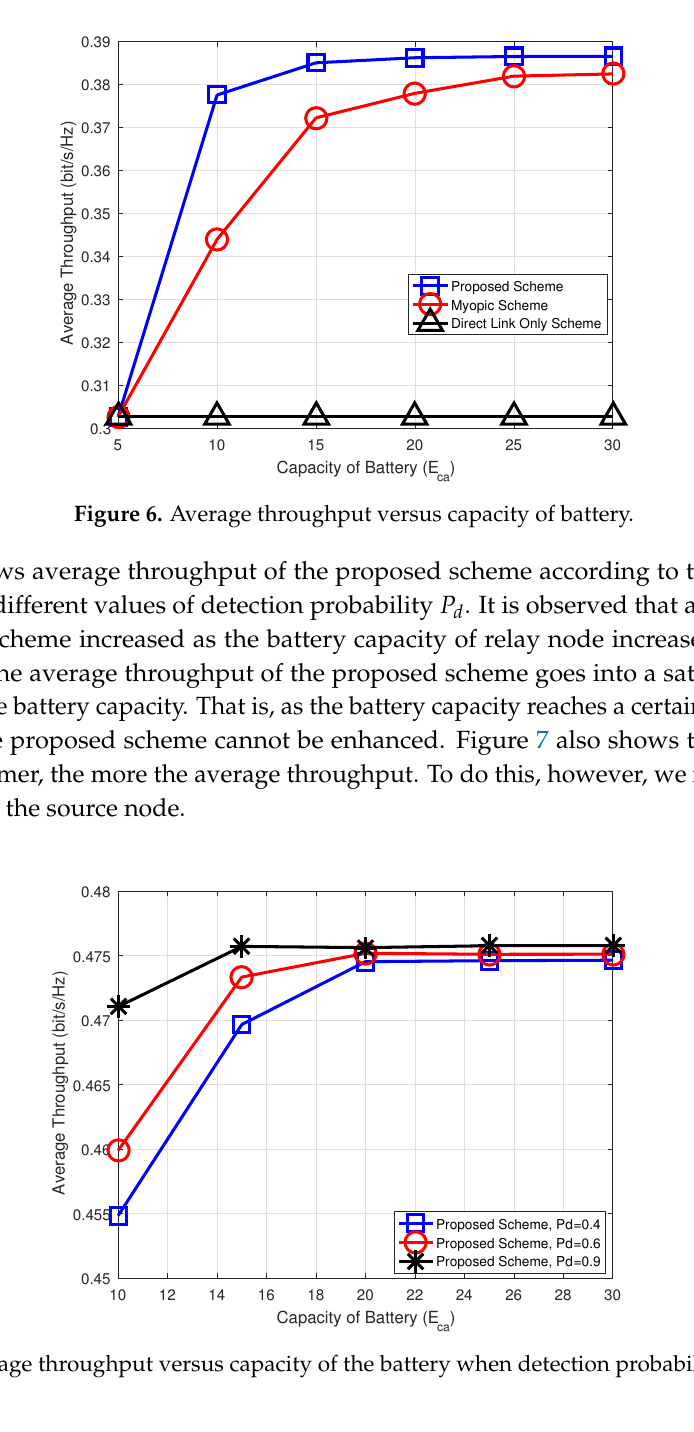
Figure 7. Average throughput versus capacity of the battery when detection probability P d = 0.4,0.6, and